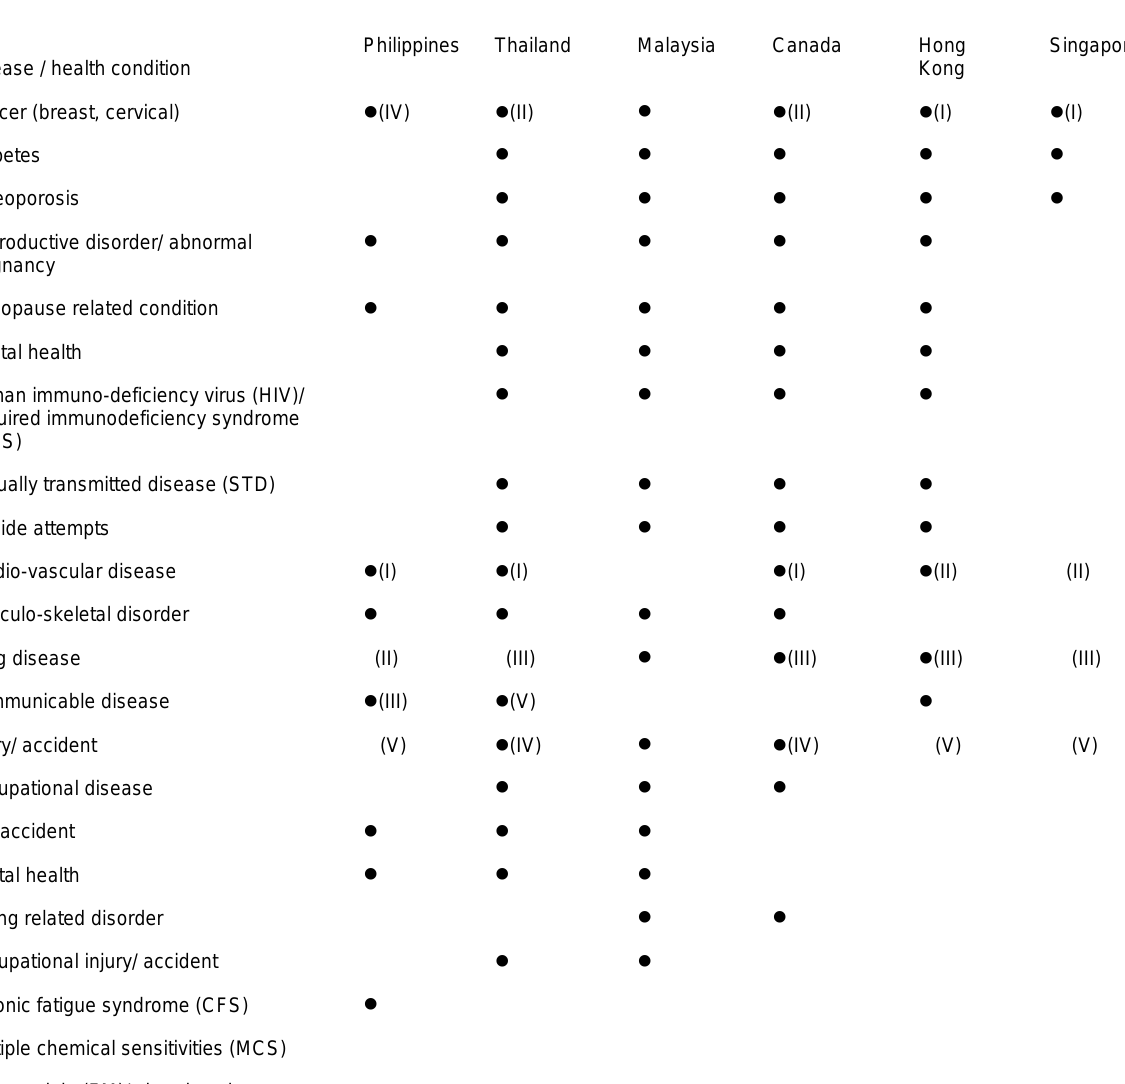
Opinion on Important Diseases and Health Conditions Affecting Women's Health, According to Key Informants During Interview, by Country/Region*